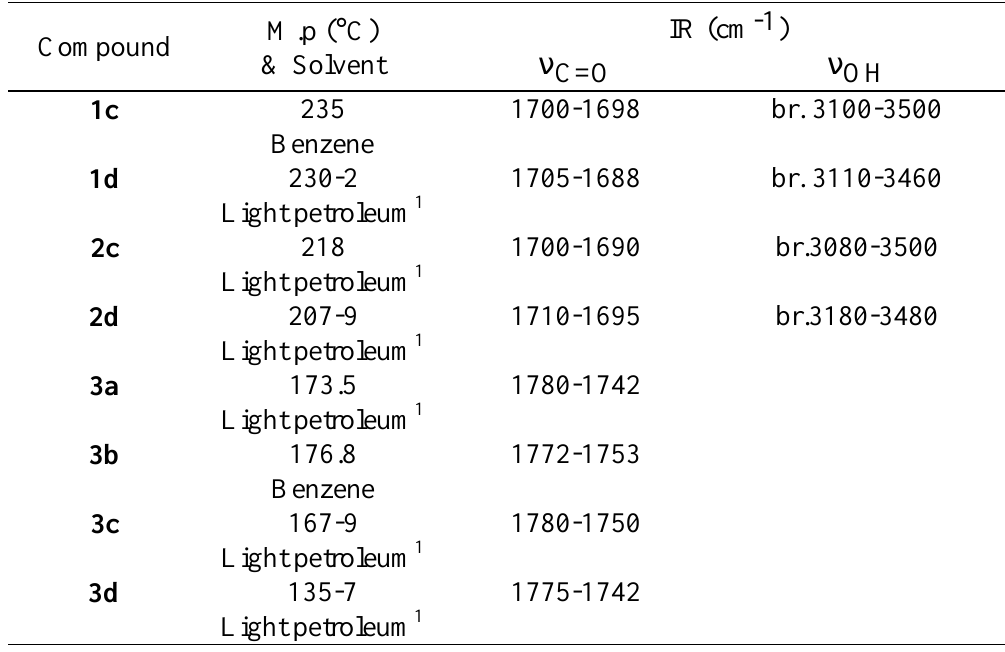
Table 1. Z - and E -isomers of 5-alkyl-4-ethoxycarbonyl-5-( 4` -chlorophenyl)-3-oxa-4-pentenoic acids and their corresponding anhydrides 1 - 3